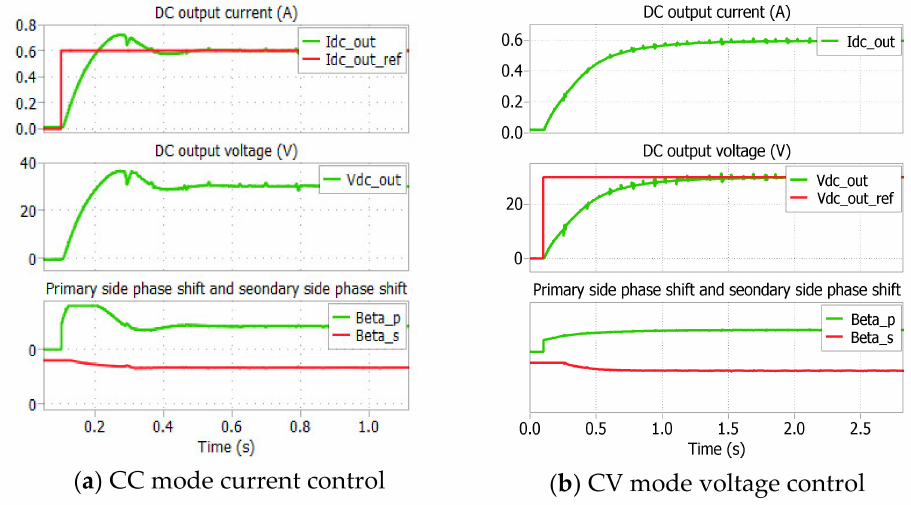
Figure 19. DC voltage/current step response in CC/CV mode control with R dc = 54 Ω